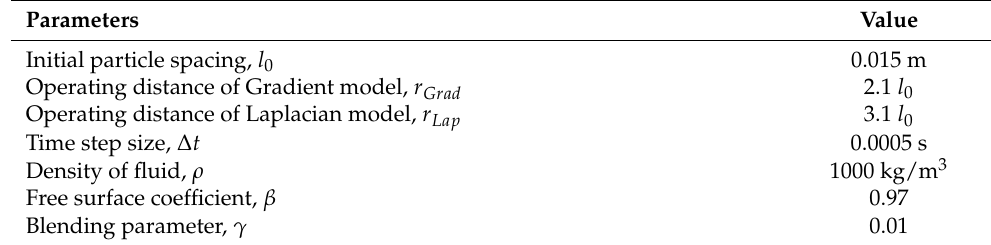
Table 6. Main calculation parameters used in the MPS method.